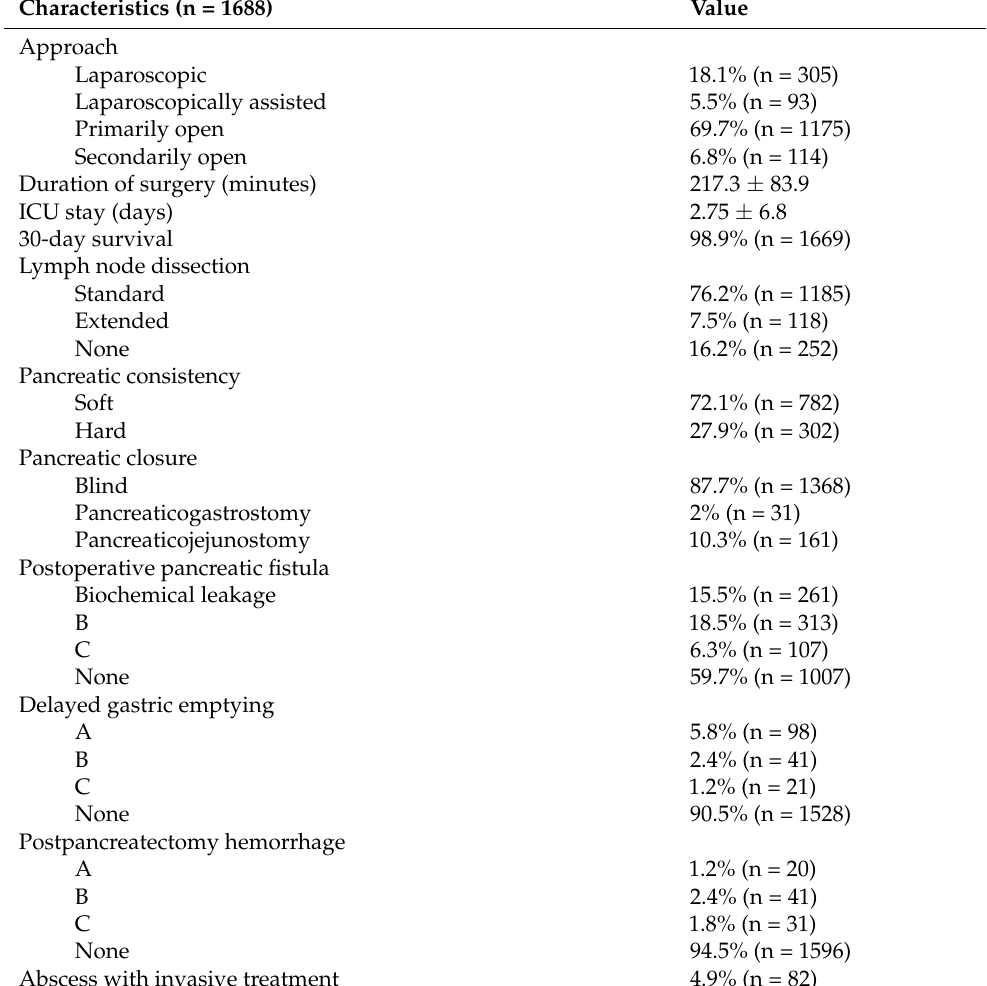
Table 1. Detailed demonstration of surgical data; abbreviations: ICU, intensive care unit; A, B, C, grades of severity of postoperative pancreatic fistulas, delayed gastric emptying and postpancreatec- tomy